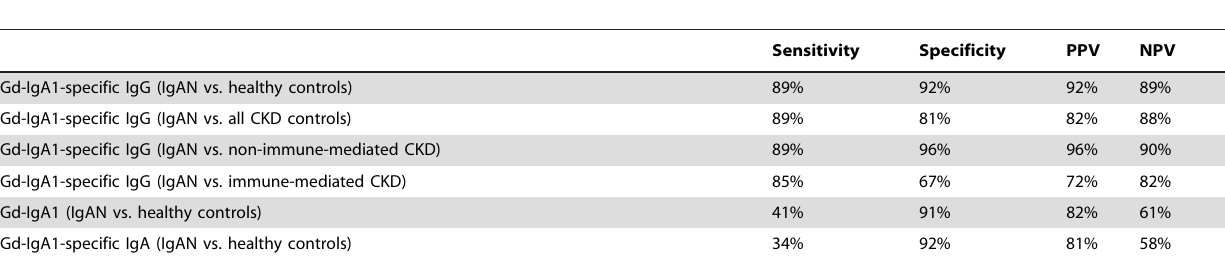
Table 5. Statistics summarized data; Discrimination between IgAN versus immune-mediated CKD and non-immune-mediated CKD controls for serum Gd-IgA1-specific IgG